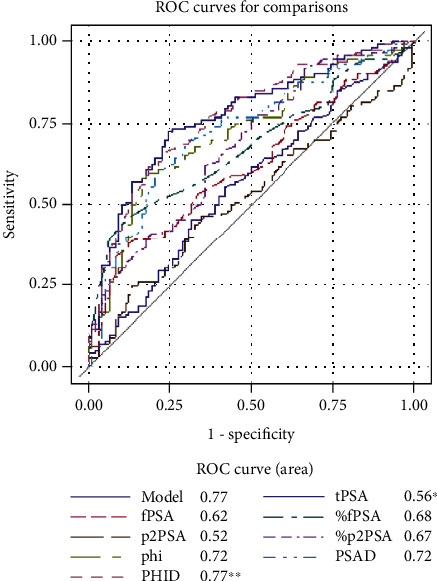
Receiver operating characteristic curves representing the diagnostic ability of blood serum biomarkers in predicting overall prostate cancer. Abbreviations: ISUP: International Society of Urological Pathology; fPSA: free prostate-specific antigen; %fPSA: free to total PSA ratio; phi: Prostate Health Index; PHID: phi density; PSAD: PSA density; ROC: receiver operating characteristic; tPSA: total PSA; %p2PSA: p2PSA to fPSA ratio. All significant differences are marked with asterisk (∗) and (∗∗): ∗P < 0.05 for tPSA vs. p2PSA, phi, %fPSA, and PSAD. ∗∗P < 0.05 for PHID vs. tPSA, fPSA, %fPSA, p2PSA, %p2PSA, and phi.